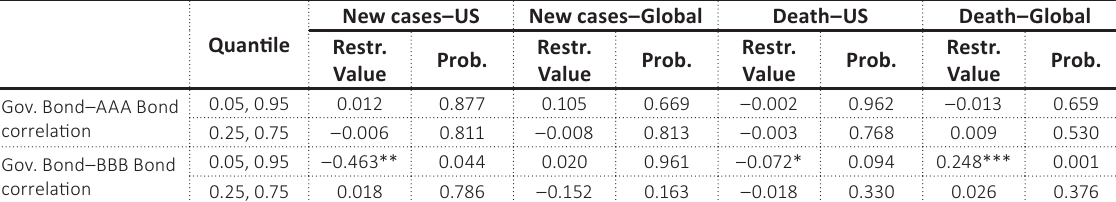
Table 3. Symmetric test for the